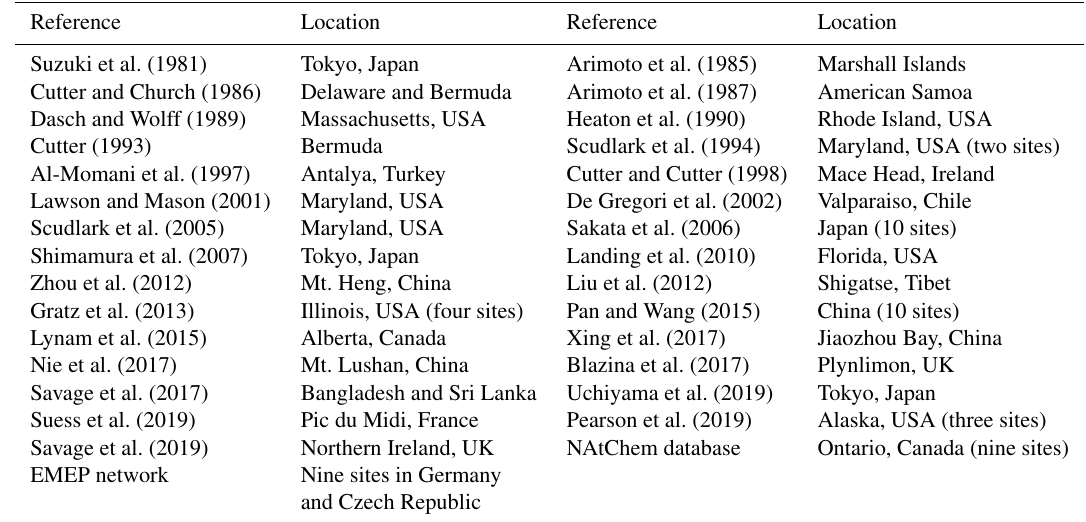
Table 5. Previous studies measuring Se wet deposition fluxes.